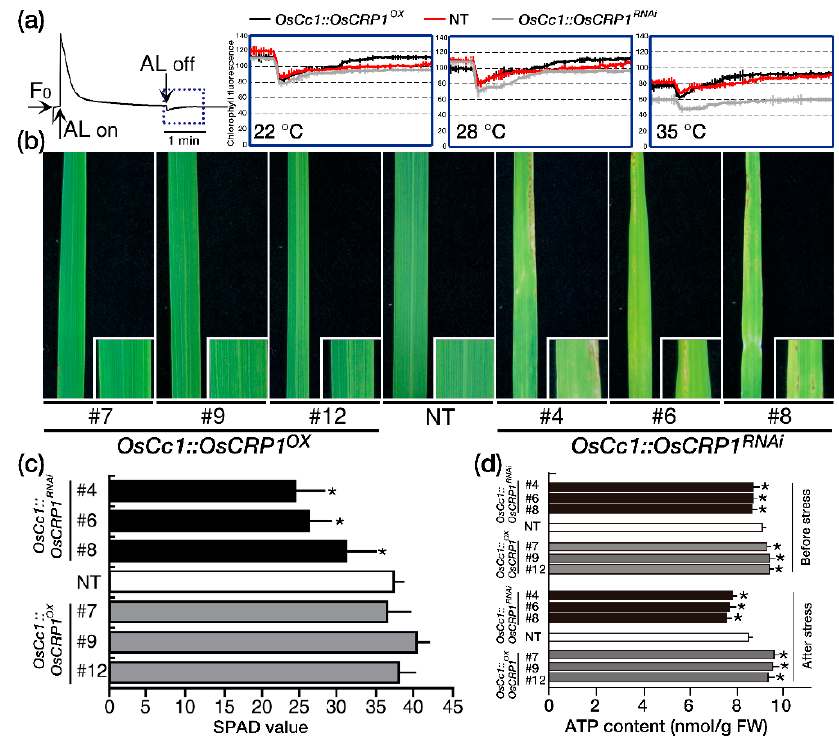
Figure 3. Monitoring of NDH-dependent CET activity by chlorophyll a fluorescence. ( a ) Chloro- phyll a fluorescence in OsCc1::OsCRP1 OX , NT and OsCc1::OsCRP1 RNAi . 5-week-old plants grown under chamber conditions. The middle portions of leaves were used for measurements. The post- illumination chlorophyll fluorescence curve, which represents NDH-dependent CET, was there- fore magnified from the blue box area for analysis. Values are means (±SD) of three independent measurements. ( b ) OsCc1::OsCRP1 OX , NT, and OsCc1::OsCRP1 RNAi plants were grown for 2 weeks under chamber conditions and light intensities of 170 ~ 180 µmol m − 2 s − 1 prior to stress treatment. Plants were then transferred to light intensities of 240 ~ 250 µmol m − 2 s − 1 and phenotyped. All light measurements were made with a LI-250A Light Meter (LI-COR, Lincoln, NE, USA), and photos were obtained 2 weeks after treatment. The analysis was carried out for three biologicals with three technical replicates each. ( c ) SPAD values for OsCc1::OsCRP1 OX , NT and OsCc1::OsCRP1 RNAi leaves, representing the amount of chlorophyll per leaf. The values were measured for 10 leaves of three representative transgenic lines and NT plants using a Chlorophyll Meter SPAD-502Plus. Data bars represent the mean ± SD of two biological replicates, each of which had three technical replicates. Asterisks indicate significant differences compared with NT (* p < 0.05, One-way ANOVA). ( d ) ATP contents in leaves of the OsCc1::OsCRP1 OX , NT and OsCc1::OsCRP1 RNAi plants under before and after light stress conditions. Ten plants were used for each line, and the middle portion of the second leaf from the top was taken for analysis. Data bars represent the mean ± SD of three biological replicates, each of which had two technical replicates. Asterisks indicate signifi- cant differences compared with NT (* p < 0.05, One-way ANOVA).